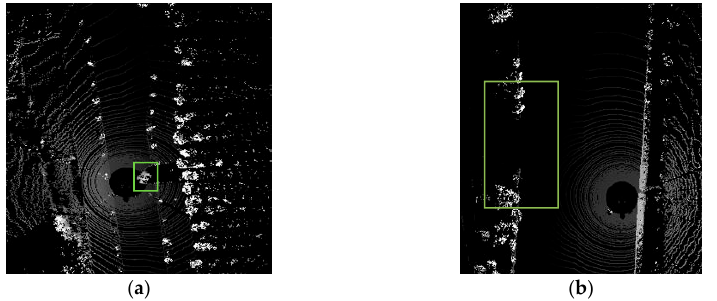
Figure 10. Two typical scenes illustrating the difficulties for road curb detection. ( a ) A car parking inside the road; ( b ) A gap exists in the road curb.